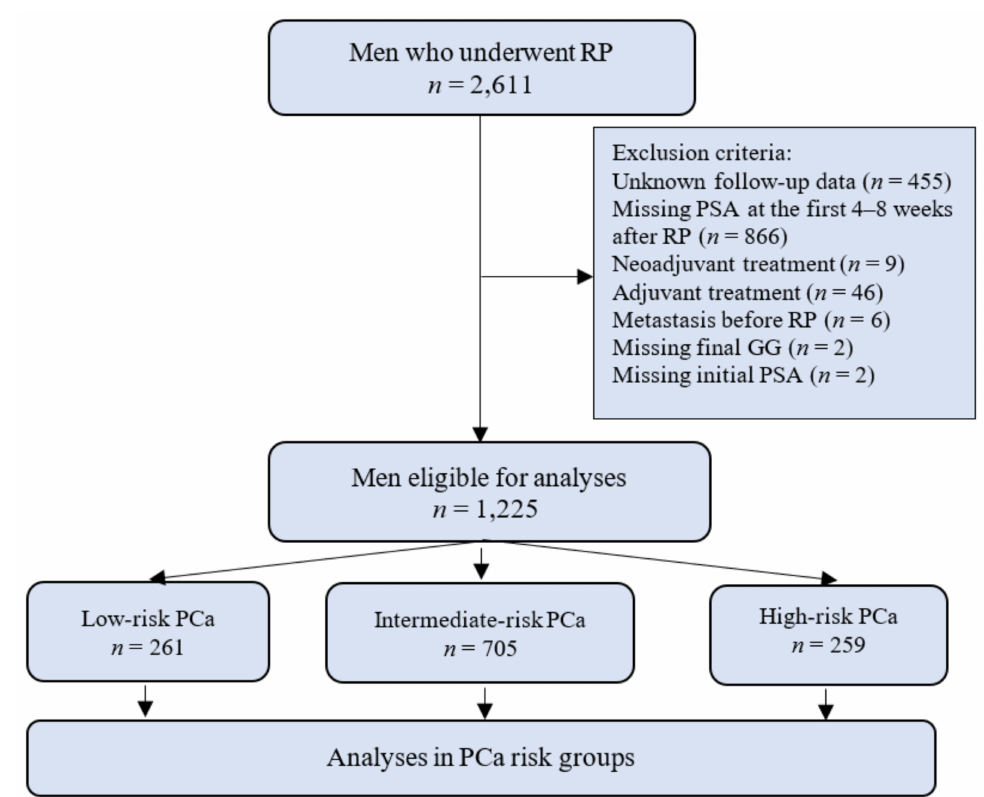
Figure 1. Study flowchart. RP—radical prostatectomy, PCa—prostate cancer, GG—grade groups and PSA—prostate- specific